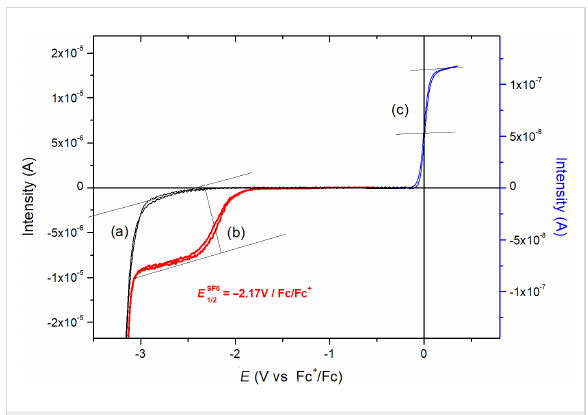
Figure 1: (a) Cyclic voltammetry onto microelectrode arrays (Ø = 20 µm) in acetonitrile freshly distilled after the addition of TBAClO 4 (0.1 M) at room temperature, under slight argon stream, v = 20 mV/s. (b) Same conditions as for (a) after addition of SF 6 . (c) Same conditions than (a) after addition of ferrocene (10 − 3 M).